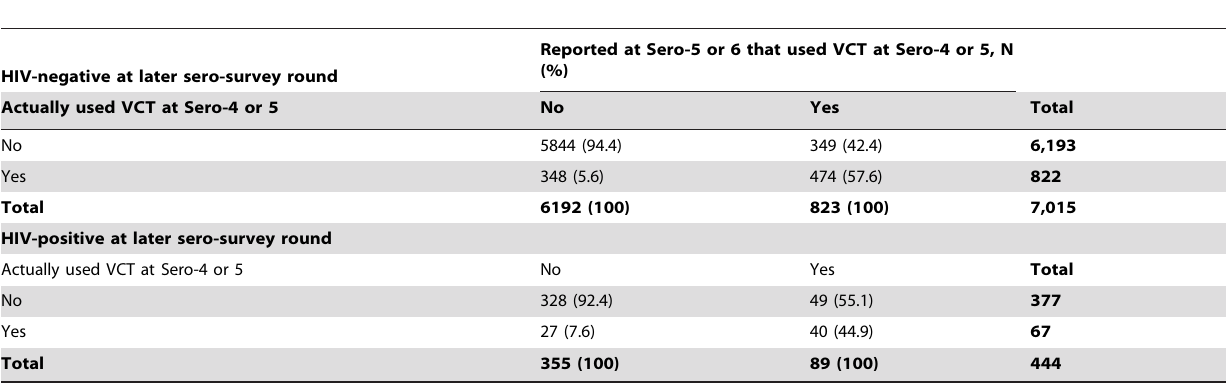
Table 4. By HIV status: number of times individuals reported using VCT at an earlier sero-survey round, versus number of times VCT was actually used at the earlier round.